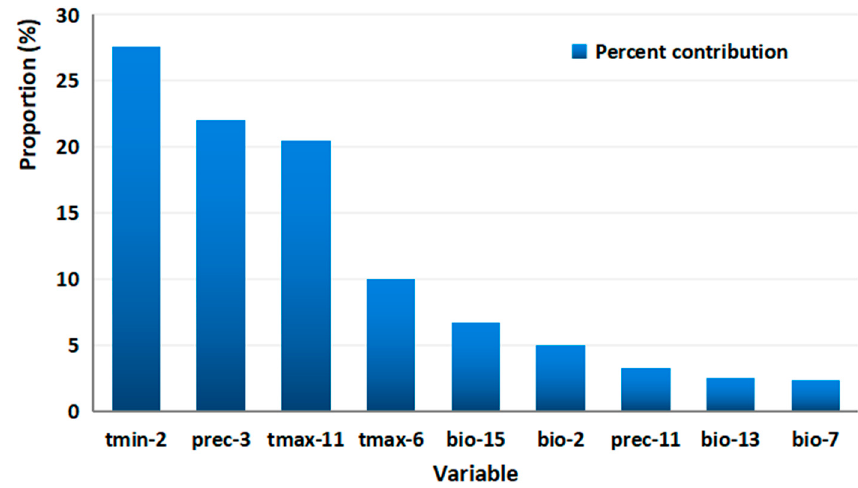
6 of 18 Figure 2. ROC curve and AUC values for the initial model ( a ) and the final model ( b ). 3.2. Dominant Environmental Factors Affecting Distribution According to the contribution rate, nine environmental factors greatly influenced the distribution range of M. destructor in the MaxEnt model (Figure 3). The nine factors had a cumulative contribution of 99.8%, and their contribution rates from high to low were as